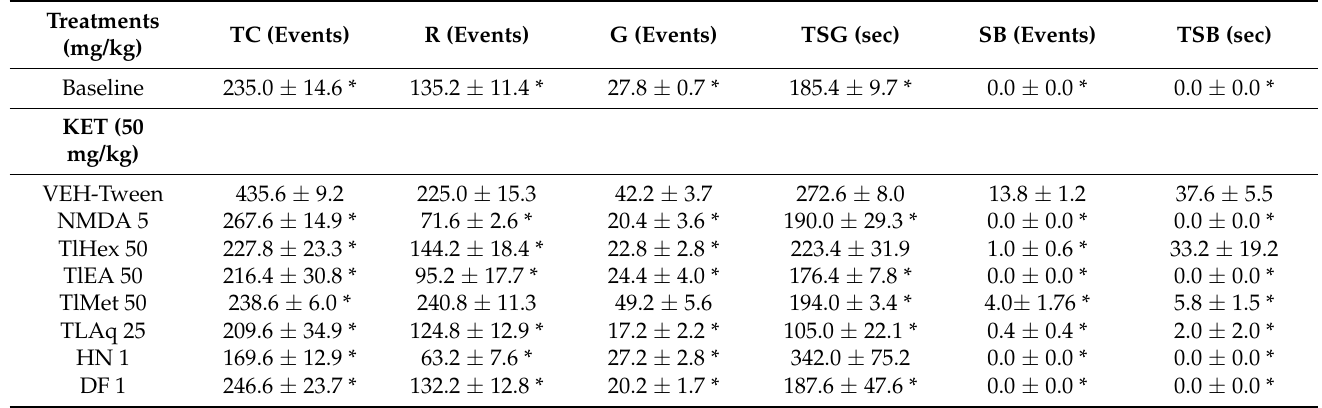
Table 1. Effect of T. lucida extracts, herniarin (HN), and dimethylfraxetin (DF) on acute schizophrenia- like symptoms induced with KET 50 mg/kg in the Open Field Test (OFT) in mice. (Observation time 30